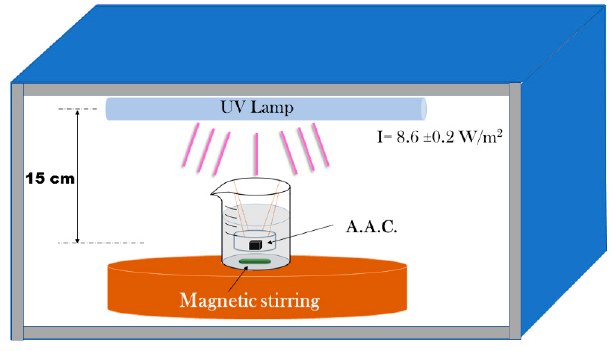
Figure 10. Experimental set up for the photocatalytic studies.